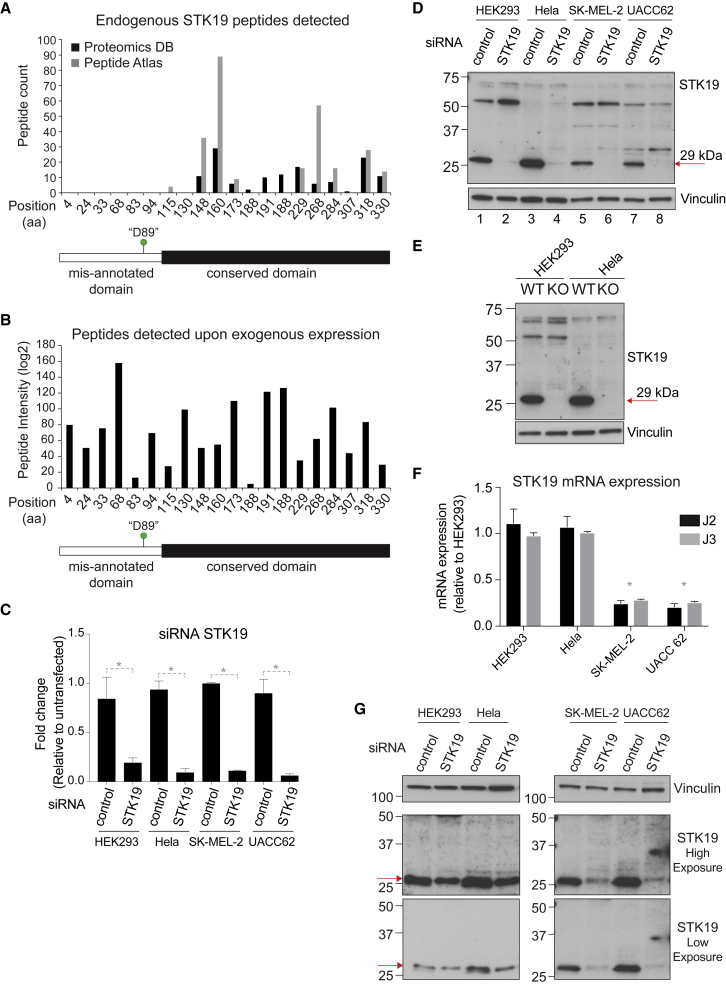
Correcting STK19 Protein Annotation(A) Graph showing STK19 peptide counts from Proteomics BD and Peptide Atlas, aligned to the amino acid position in STK19, above a schematic representation of STK19 as currently annotated showing the conserved domain, the miss-annotated domain and the position of “D89” mutation.(B) As in (A), but showing average peptide intensity found by mass spectrometry analysis of overexpressed, immunoprecipitated 41 kDa STK19 protein.(C and D) siRNA of STK19 in HEK293, HeLa, and melanoma cell lines SK-MEL-2 and UACC 62. C, Graph showing the STK19 mRNA expression relative to control. ΔCT values were calculated relative to GAPDH before comparing to control. Error bars represent ± SD. Statistically significant differences (p < 0.05, multiple t tests, Holm-Sidak correction) of three replicates are indicated with asterisks.(D) Western blot of STK19. Vinculin is used as loading control. 75 μg of whole cell extract were loaded per lane. Arrow on the right indicates the only specific STK19 band detected, corresponding to the 29 kDa protein. (E) Western blot of whole cell extract of STK19 wildtype and knock-out cell lines (HEK293 and HeLa). 75 μg of total whole cell extract loaded per lane. Arrow on left indicates the only band that disappears after gene knockout, the 29kDa species.(F) qPCR data of STK19 mRNA expression in the cells used in (C and D). ΔCT values were calculated relative to GAPDH before normalizing to the expression level in HEK293. Error bars represent ± SD. Asterisks indicate statistically significant differences (p < 0.05, multiple t tests, Holm-Sidak correction) of three replicates of HeLa or 293 compared to SK-MEL-2 and UACC 62 for both J1 and J2.(G) Western blot of STK19 in extracts from HEK293, HeLa, and melanoma cell lines SK-MEL-2 and UACC 62, following the protocols provided by Yin et al. 2 different exposures are shown. Red arrow indicates the position of STK19; no band is visible at 41 kDa. siRNA of STK19 was less efficient than in 2D.